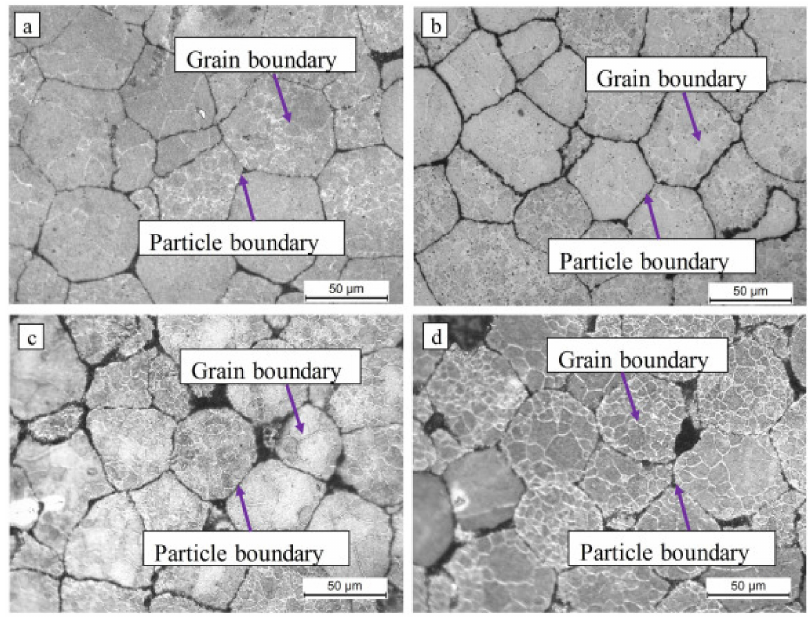
Figure 7. Optical micrographs showing the microstructures of samples: ( a ) ZK61, ( b ) ZK61/5 β -TCP, ( c ) ZK61/10 β -TCP and ( d ) ZK61/15 β -TCP